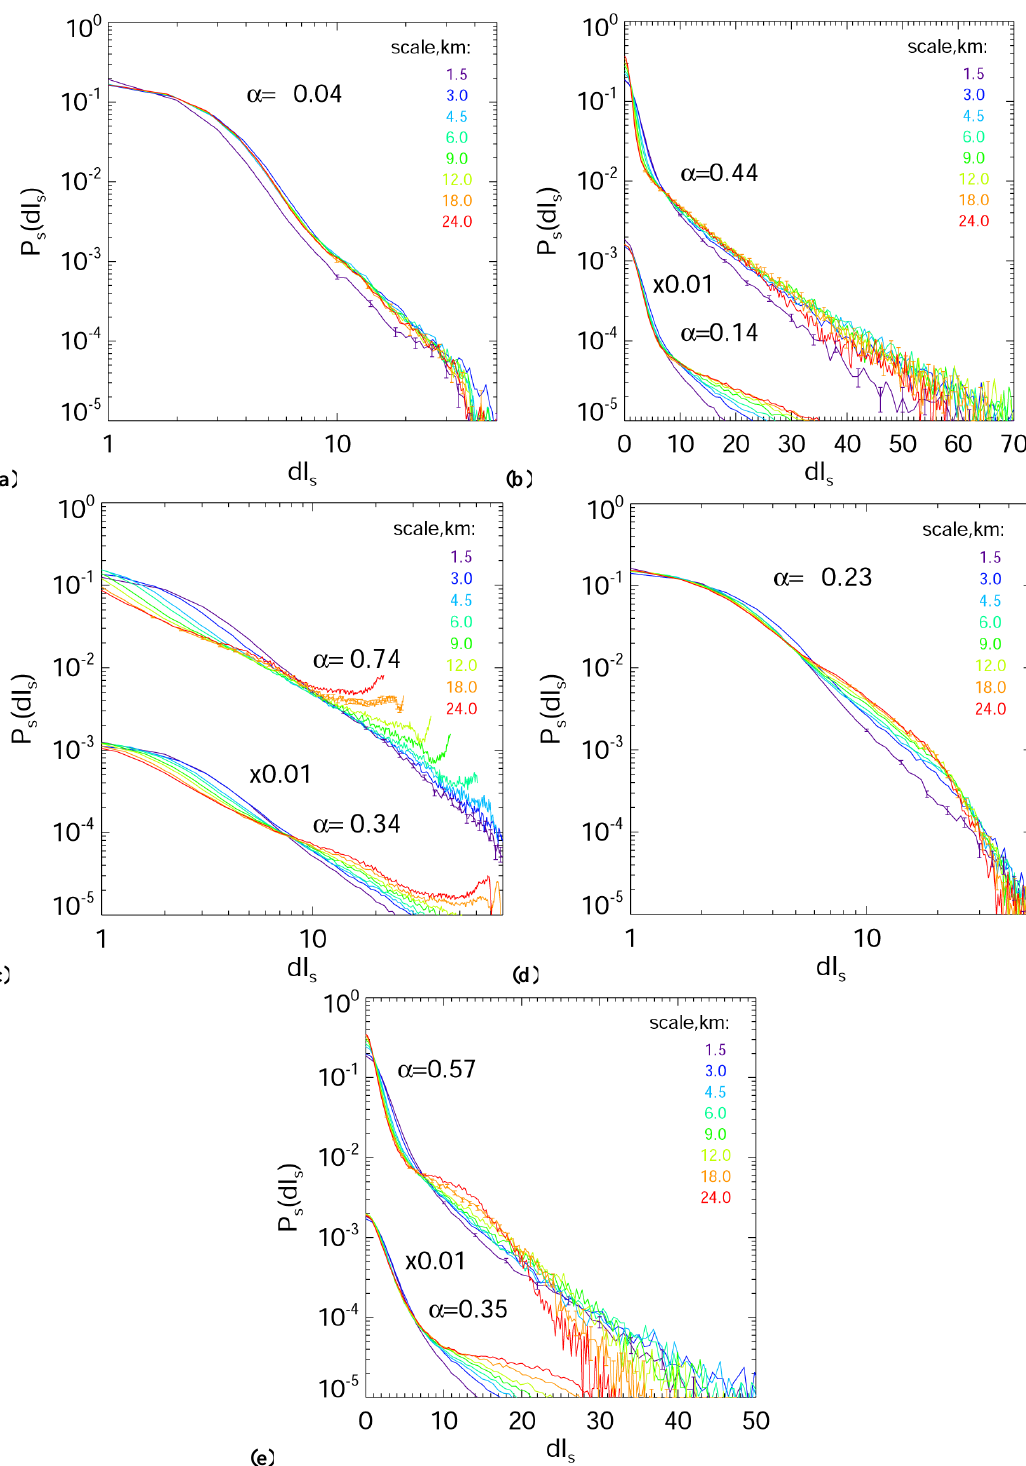
Fig. 6. Scaling collapse of the PDFs for cases from Fig. 3. For (b) , (c) , and (d) – two sets of curves are presented with different values of the scaling